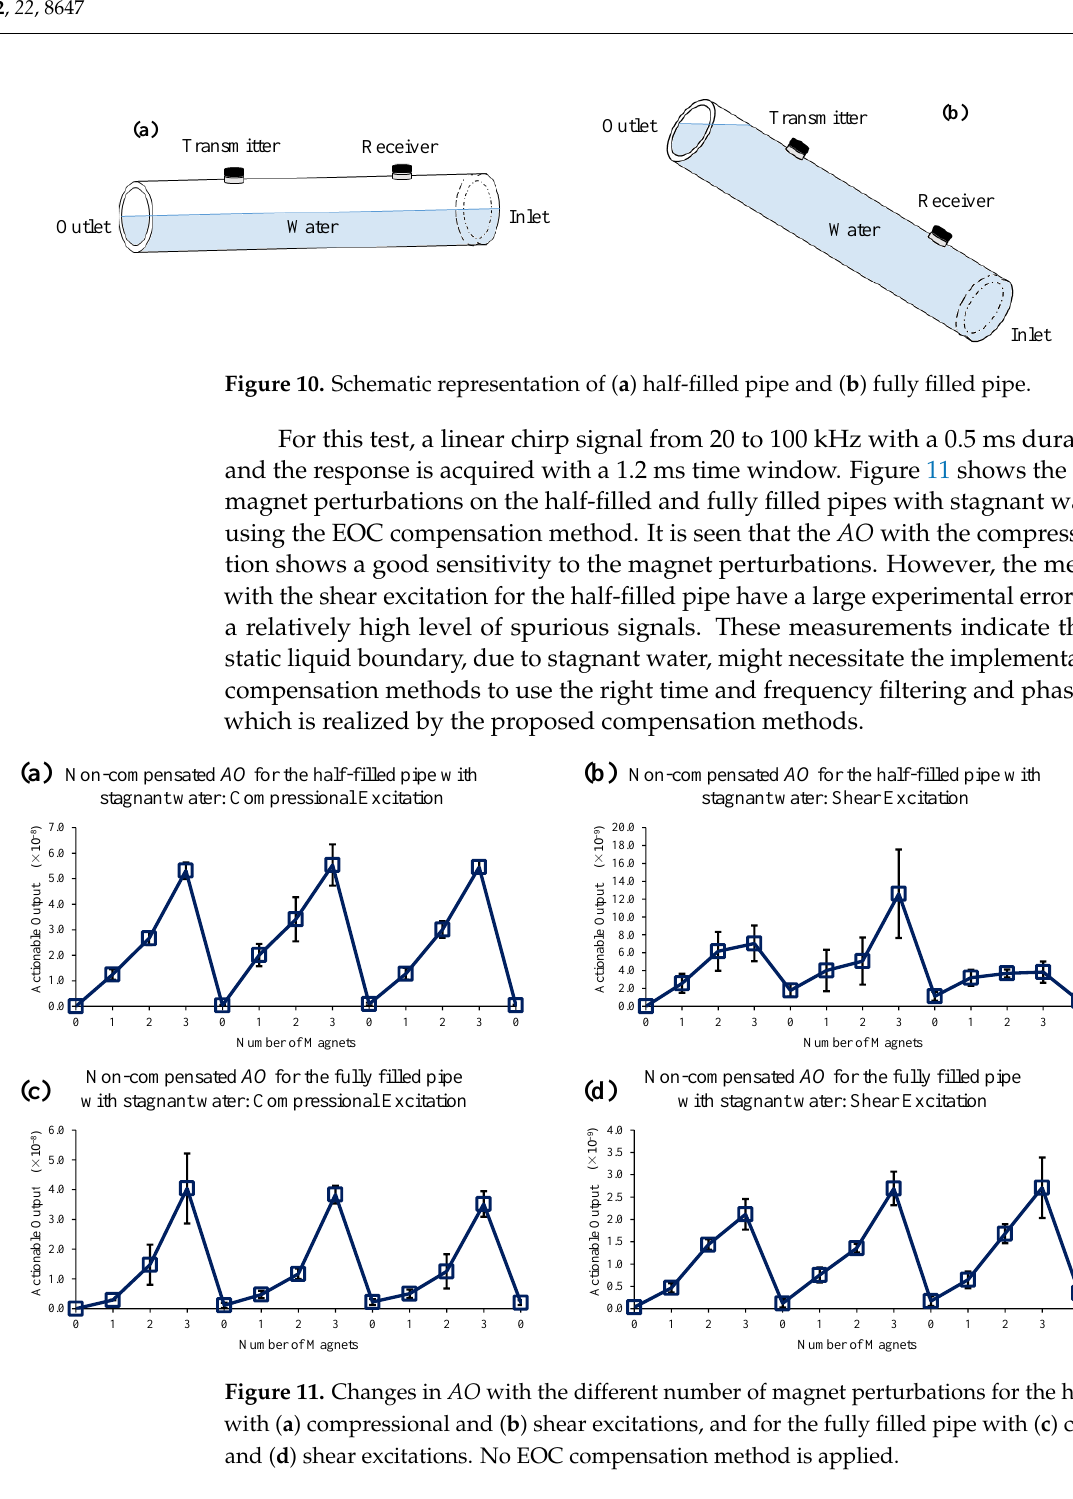
9 of 16 Based on this positive result, similar time and frequency filtering are used for the measurements reported in the rest of the paper. Figure 9 shows that AO with the empty pipe can track the magnet perturbation effect with high accuracy without the need for two-level EOC compensation. In addition, in this empty pipe case, both compressional and shear excitations provide similar sensitivity to the given mechanical changes. Figure 9. Changes in AO with the different numbers of magnet perturbations for the empty pipe with ( a ) compressional and ( b ) shear excitations. No EOC compensation is applied. 4.2. Stagnant Water